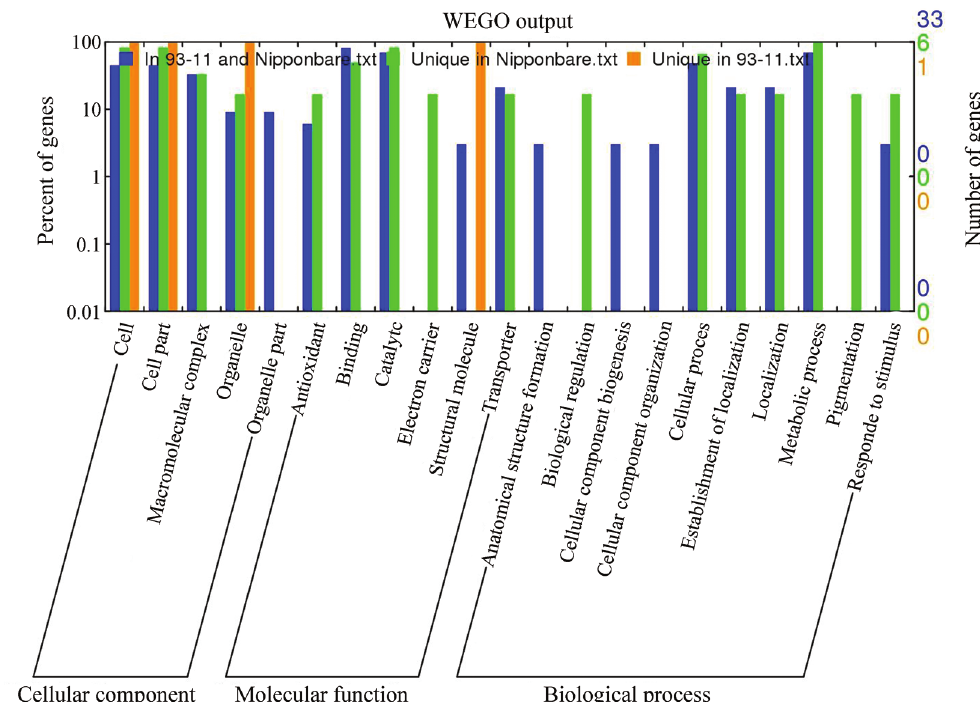
Figure 4 - Gene ontology (GO) categories of the identified differentially expressed proteins in 93-11 and Nipponbare. These proteins were divided into three main categories and 21 subcategories (Ye et al. , 2006).